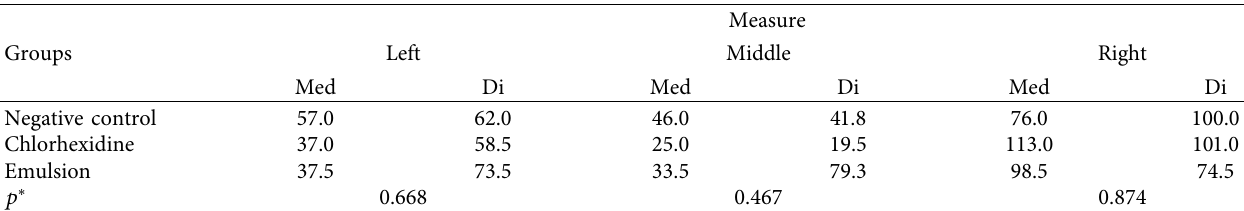
Table 3: Comparison in relation to groups for each measure of the Adper Single Bond 2 ™ adhesive system, Manaus, AM. Measure Groups Left Middle Right Med Di Med Di Med Di Negative control 4.5 30.0 5.5 26.2 19.2 Chlorhexidine 4.0 39.8 Emulsion 53.5 89.3 50.5 99.8 56.5 b 75.0 p ∗ 0.124 0.272